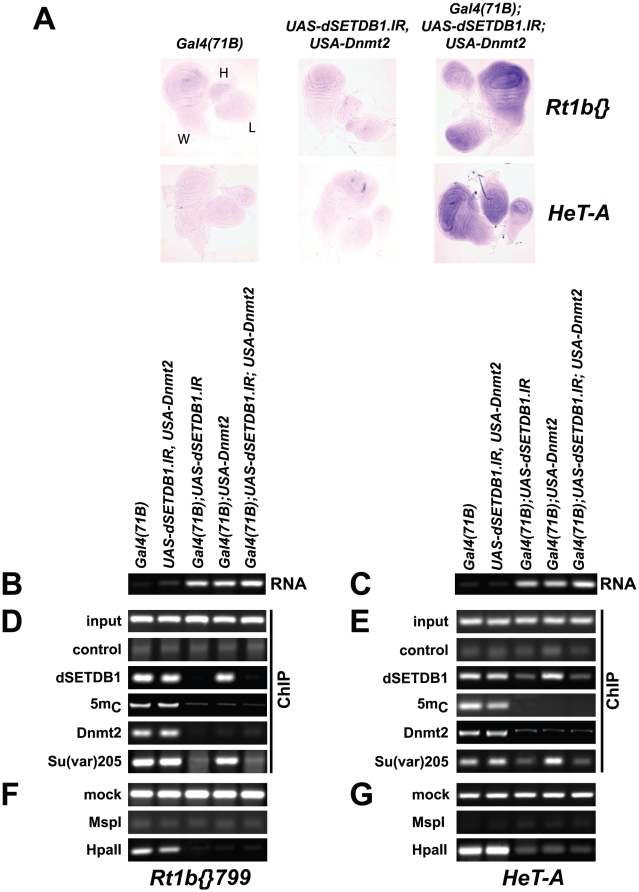
DSETDB1-mediated DNA methylation mediates silencing of Rt1b{} and HeT-A retrotransposons in the developing wing.(A) In situ hybridization assays detecting Rt1b and HeT-A transcription in wing (W), haltere (H), and third-instar leg (L) imaginal discs isolated from third-instar larvae, which ubiquitously express Gal4 [Gal4(71B)], contain the reporter construct USA-Dnmt2 and UAS-dSETDB1.IR or lack dSETDB1 [Gal4(71B);UAS-dSETDB1.IR], Dnmt2 [Gal4(71B);USA-Dnmt2], or both [Gal4(71B);UAS-dSETDB1.IRGal4(71B);USA-Dnmt2] by RNAi. (B,C) RvT-PCR assays monitoring the transcription of Rt1b{} and HeT-A retrotransposons in wing imaginal discs described in (A). RNA was isolated from 50 wing discs and reverse transcribed. PCR detected the presence of (A) Rt1b{} and (D) HeT-A transcription. (D,E) Digital images of ethidium bromide-stained agarose gels showing the reaction products of PCR assays detecting the presence of (B) Rt1b{} and (E) HeT-A in DNA pools generated by ChIP. Chromatin was isolated from in vivo cross-linked wing imaginal discs isolated from larvae of the genotype described in (A,D). Chromatin was immunoprecipitated with antibodies to dSETDB1, 5mC, Dnmt2, Su(var)205, and rabbit serum (control). Input represents the amount of retrotransposons detectable in 2.5% of the input material. (F,G) Digital images of ethidium bromide-stained agarose gels showing the reaction products of methylation-sensitive restriction analyses with genomic DNA isolated from wing imaginal discs described in (A). Genomic DNA was isolated, incubated with bovine serum albumin (BSA) (mock), the methylation-sensitive restriction endonuclease HpaII, or the methylation-insensitive restriction enzyme MspI. PCR assays monitored the presence of the (C) Rt1b{} and (F) HeT-A in treated DNA pools.